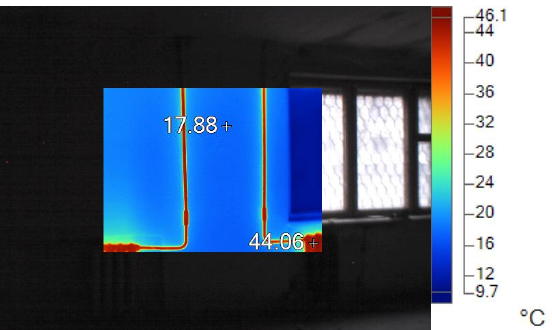
Figure 5. Photo of the scheme of placing the heat flux sensors on the outer side of the building wall under investigation. With the temperature control of the wall surface performed by the thermal IR Camera Fluke TI 50 with absolute error ±2 K, the temperature values from 17 to 17.9 °C were reg ‐ istered. After installation of the heat flux sensors the built ‐ in L ‐ type thermocouple with